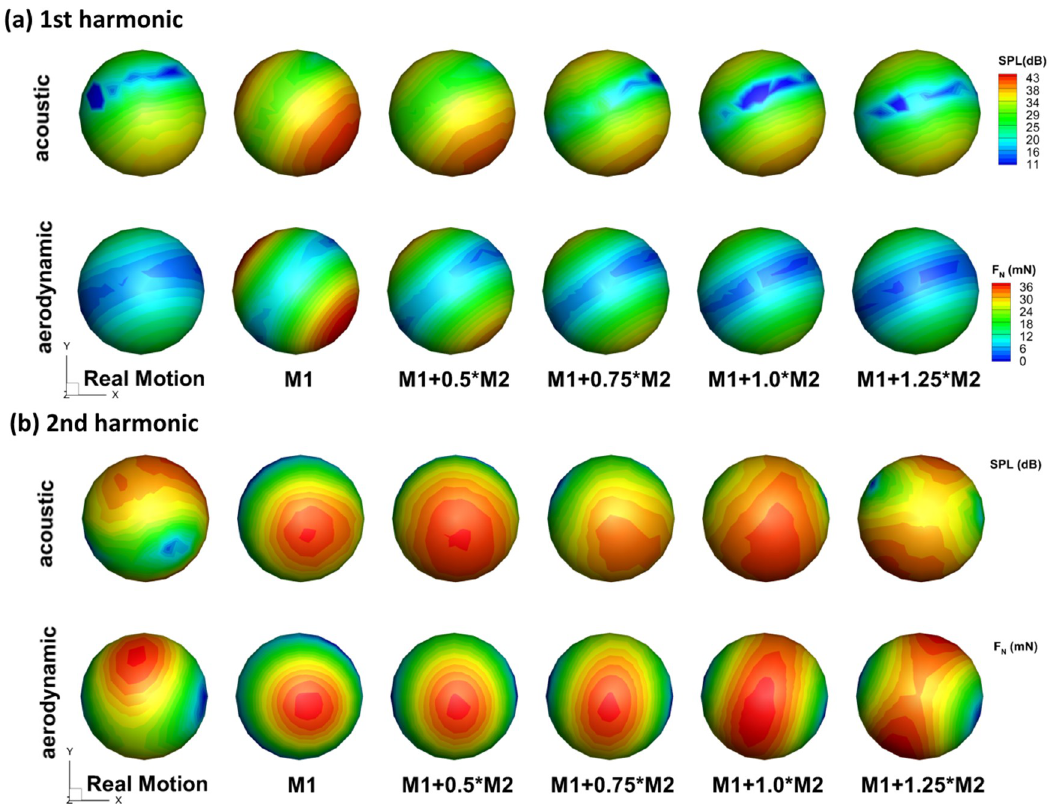
Figure 5. Comparison of acoustic signal pattern ( top row ) and aerodynamic signal ( bottom row ) pattern for the stroke frequency ( a ) and the second harmonic ( b ) (note different contour levels are used for different models to compare the pattern for the second harmonic).